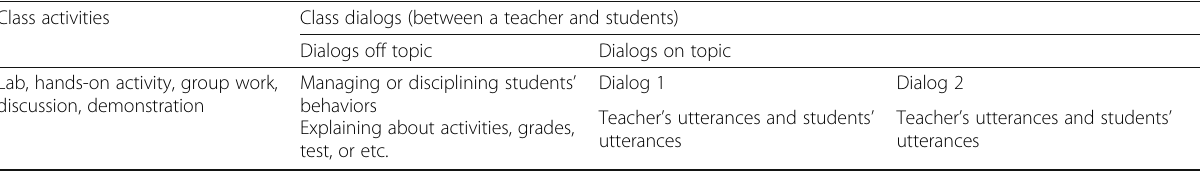
Table 1 Class activities vs. class dialogs between a teacher and